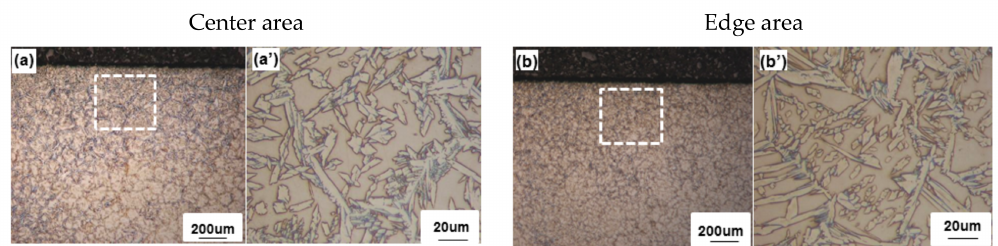
Figure 7. Microstructural analysis at the edge and the center of weld metal of high heat input; ( a , a’ ) Reheated WM at the center; ( b , b’ ) Reheated WM at the edge.